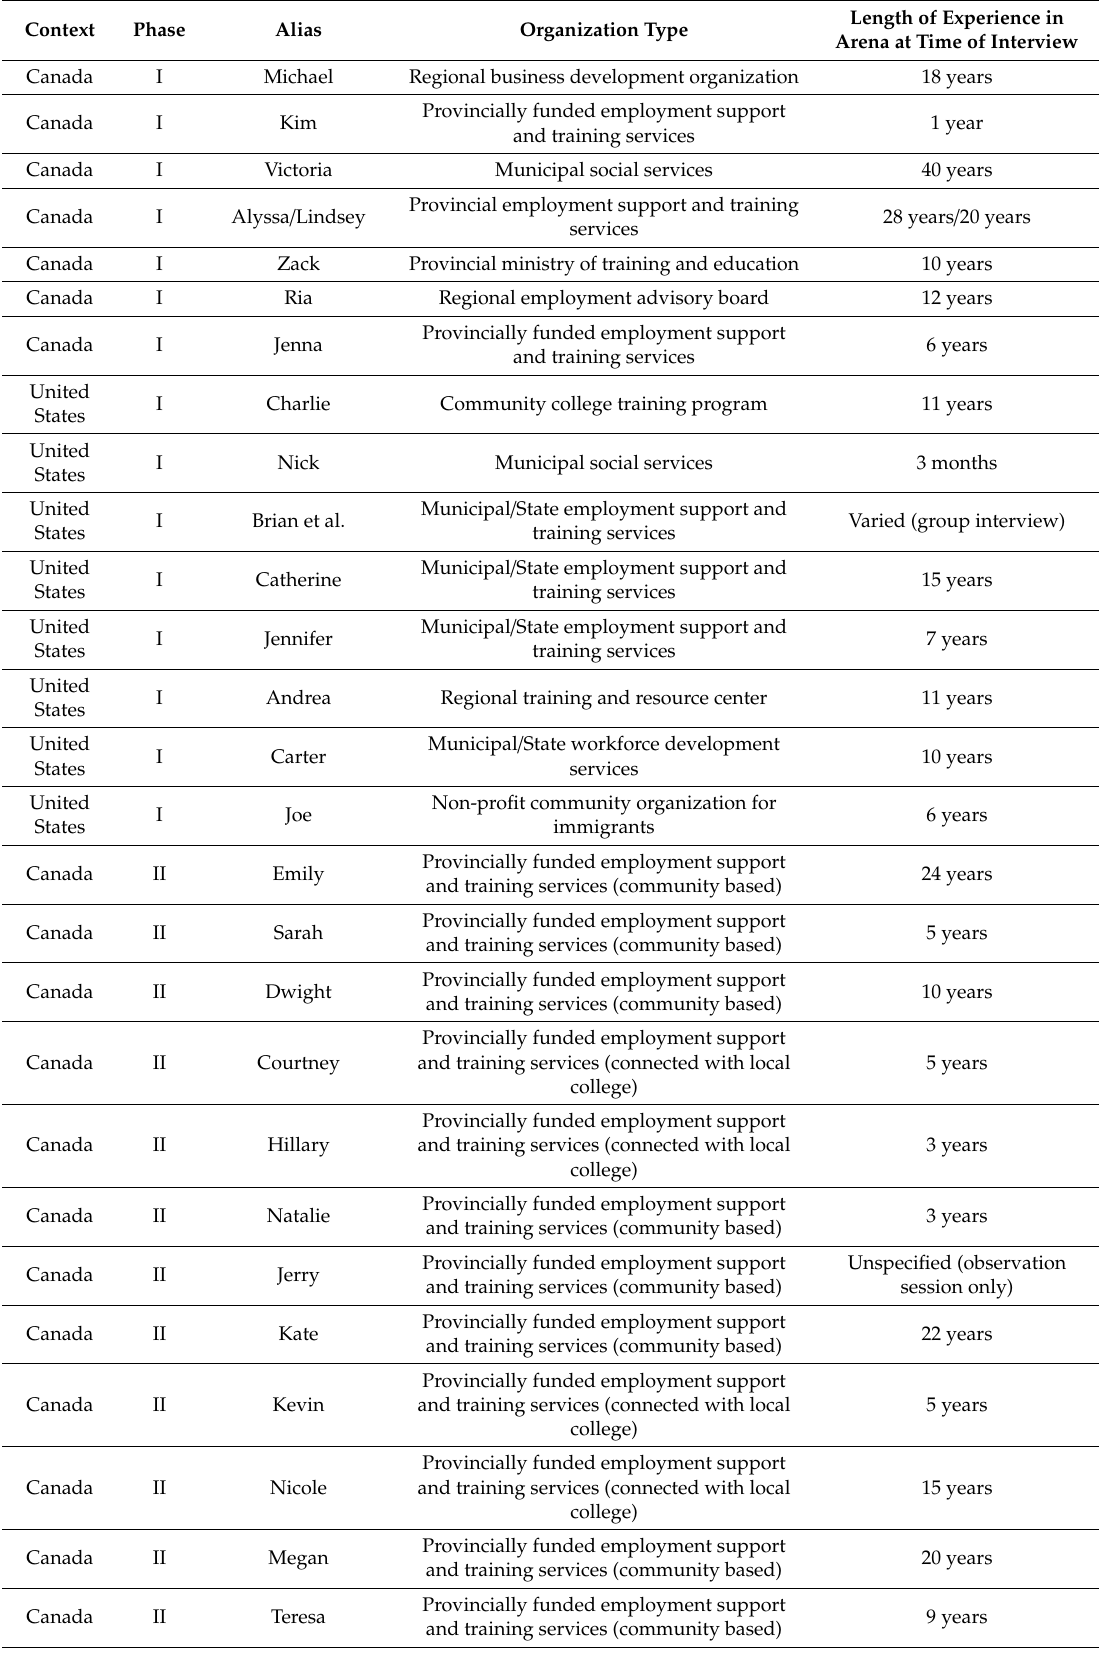
Table 1. Phases I and II participant